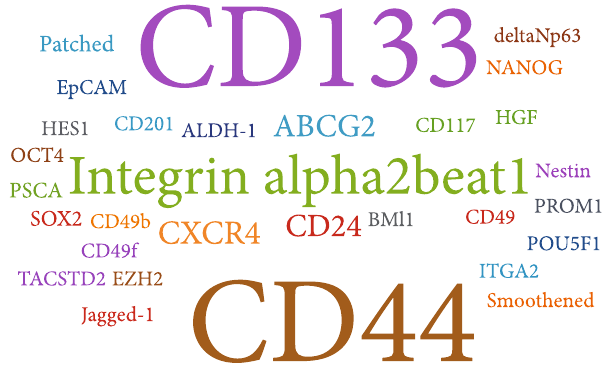
Figure 1: Word cloud: visualization of the surface markers for prostate